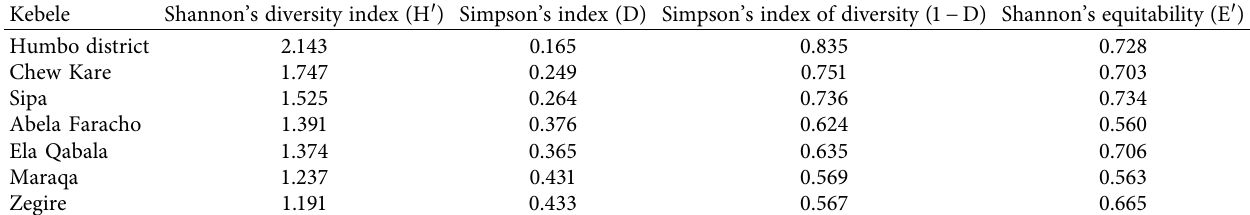
Table 5: Diversity of species in